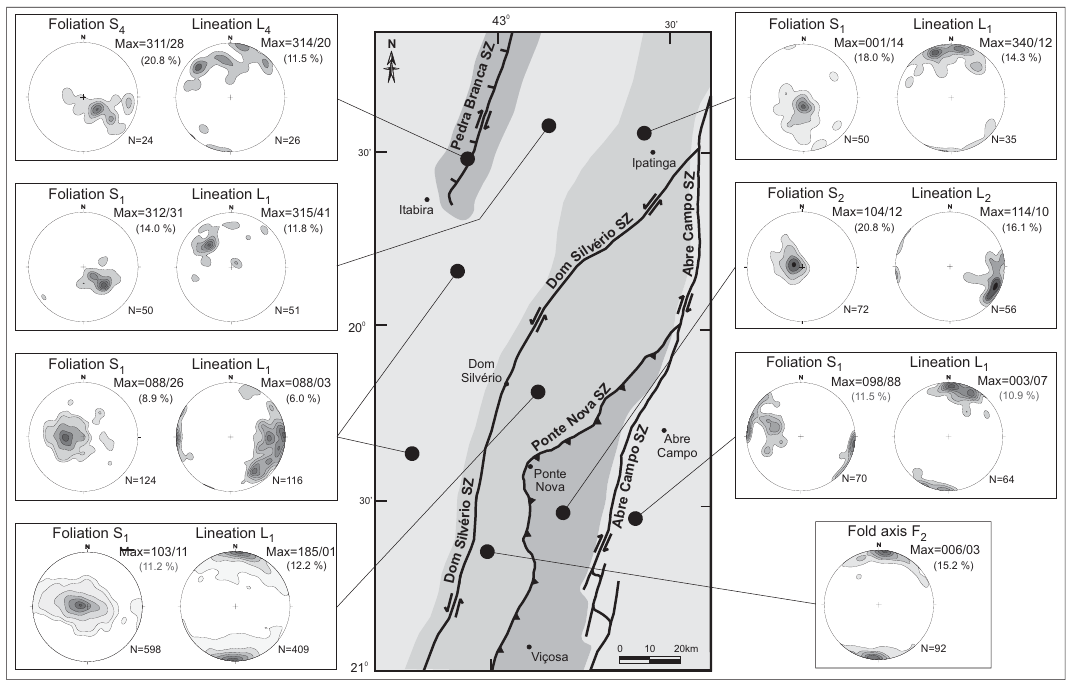
Fig. 7 – Stereographic diagrams of D 1 , D 2 and D 4 structures in the study